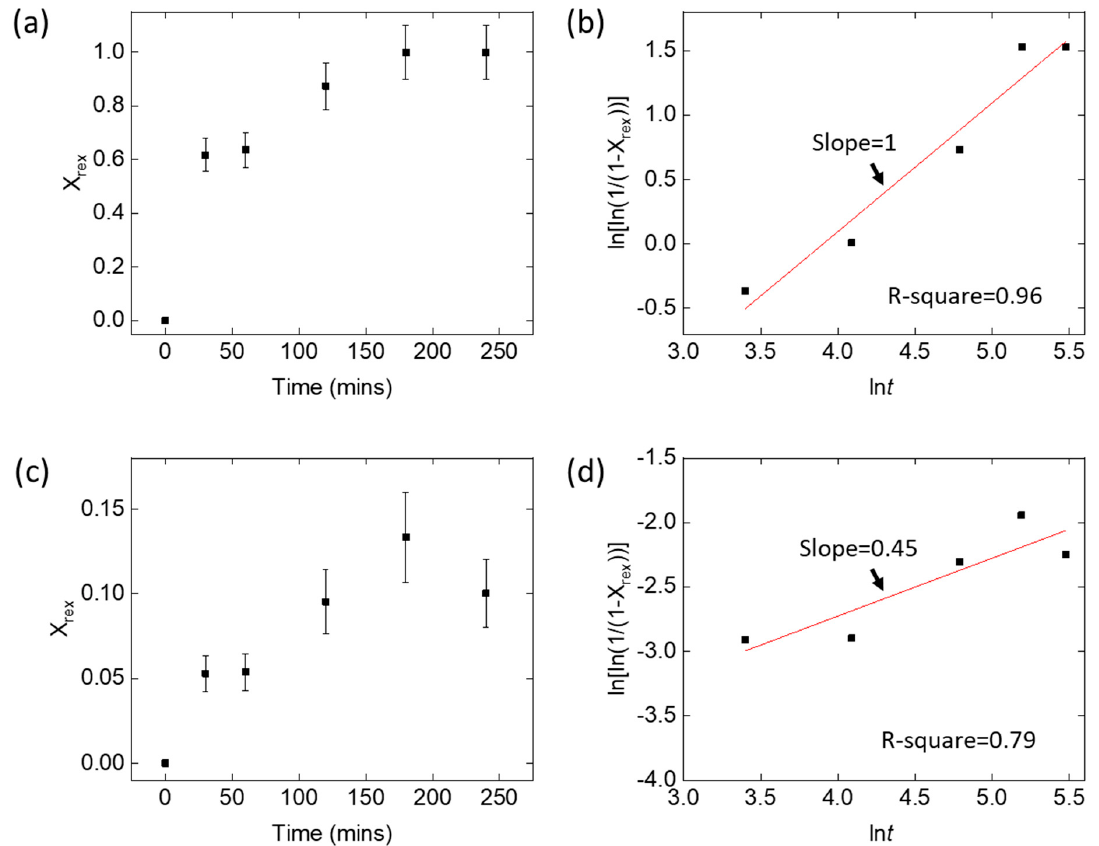
Figure 4. ( a ) Recrystallization fraction as a function of time, ( b ) plot of ln [ ln (1/(1 − X rex ))] as a function of lnt in the FeCrAl alloy annealed at 1000 °C; ( c ) recrystallization fraction as a function of time, ( d ) plot of ln [ ln (1/(1 − X rex ))] as a function of lnt in the 14YWT alloy annealed at 1100 °C. 14YWT alloys are extremely stable at high